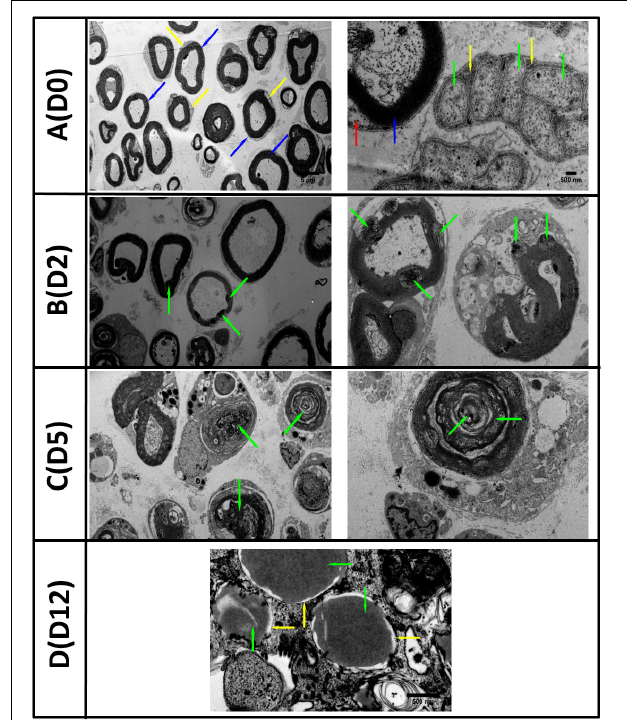
FIGURE 1 | TEM images of in vitro Wallerian degeneration model showing ongoing degeneration of the nerve axons and myelin. (A) (D0 left) Healthy rat sciatic nerve at day zero (D0) showed preserved myelin structures (blue arrows) and surrounded by Schwann cells cytoplasm (yellow arrow). (A) (D0 right) Nerve at higher magnification with regular myelin lamellae (blue arrow) and Schwann cell nucleus (red arrow). Multiple unmyelinated axons (green arrow) surrounded by Remak Schwann cell (yellow arrow) grouped in Remak bundles were also observed . (B) (D2 left) The second day (D2) post transection, the Wallerian Degeneration (WD) was evidenced by the appearance of multiple vacuoles within the myelin structures (green arrows) with the collapse of myelin evident at higher magnification (B) (D2 right). (C) Five days (D5) post in vitro WD we observed the disappearance of axonal structures and abundance of myelin debris within Schwann cell cytoplasm (green arrows). (D) Twelve days (D12) post transection and WD, the axons were replaced with amorphous material (green arrows) and myelin structures disappeared (yellow arrows) (Scale bars as in the top row are 5 µ m on the right and 500 nm on the